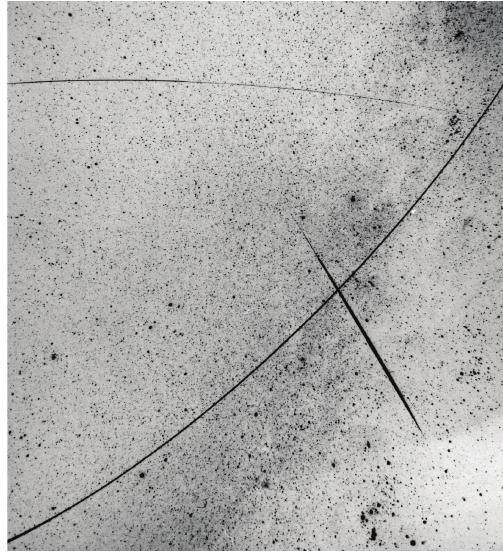
Figure 5: Ondrejov Observatory EN network photographic plate, central part (converted to negative). The EN network uses fish-eye lenses F-Distagon 3.5/30, and the images are recorded on planfilms 90 × 120mm; sky diamater is 80 mm and typical exposure time 3 hours resulting in limiting magnitude 11.